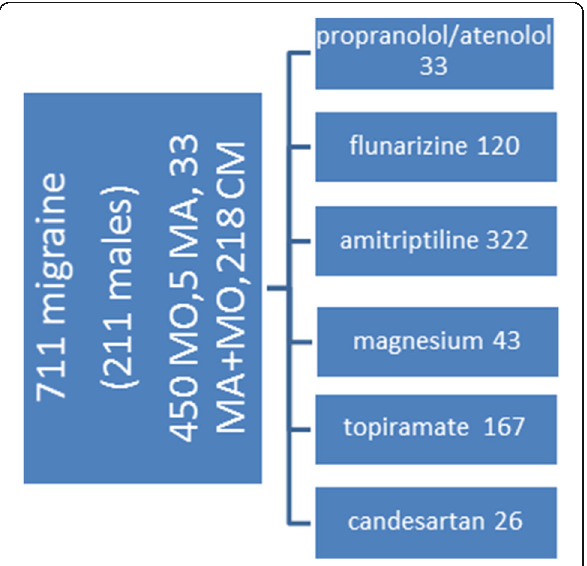
Fig. 4 Patients and preventive therapy